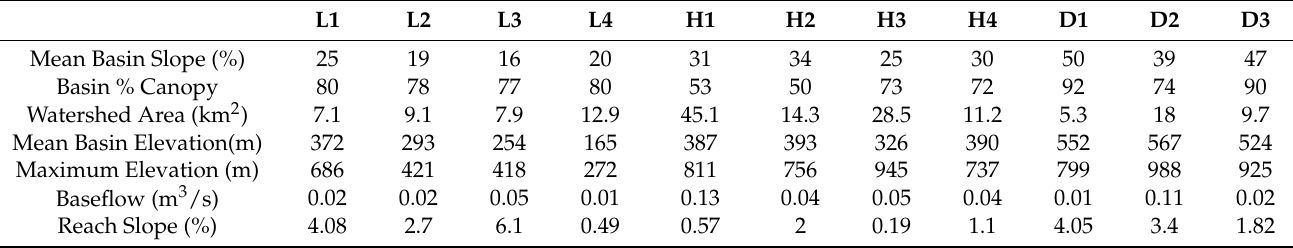
Table 1. Reach characteristics on eleven reaches: immutable watershed characteristics calculated with GIS with baseflow and reach slope field measured at low flood ( L ), high flood ( H ), and debris flow ( D ) disturbance categories.